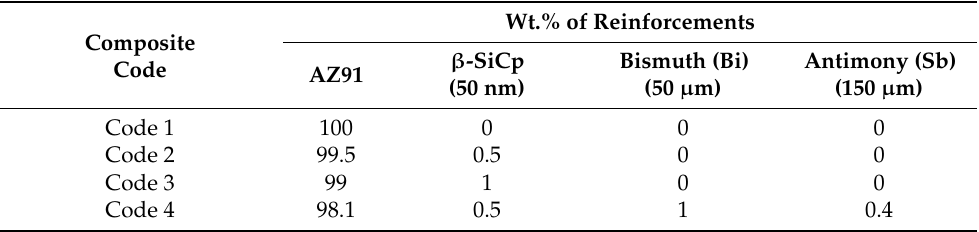
Table 2. Weight percentages of the investigated composites with reinforcements and their codes. Composite